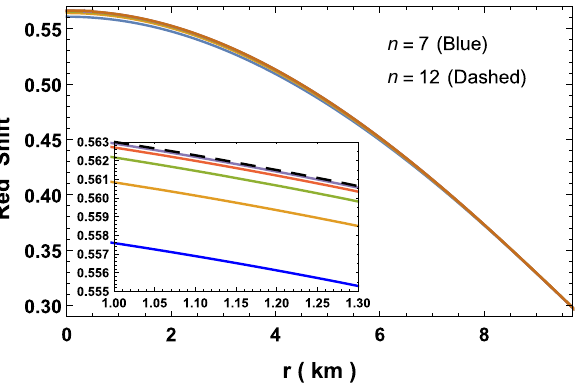
Fig. 7 Red-shift profiles of PSR J1614-2230 for M = 1 . 97 M (cid:6) , R = 9 . 69 km and b = 0 .